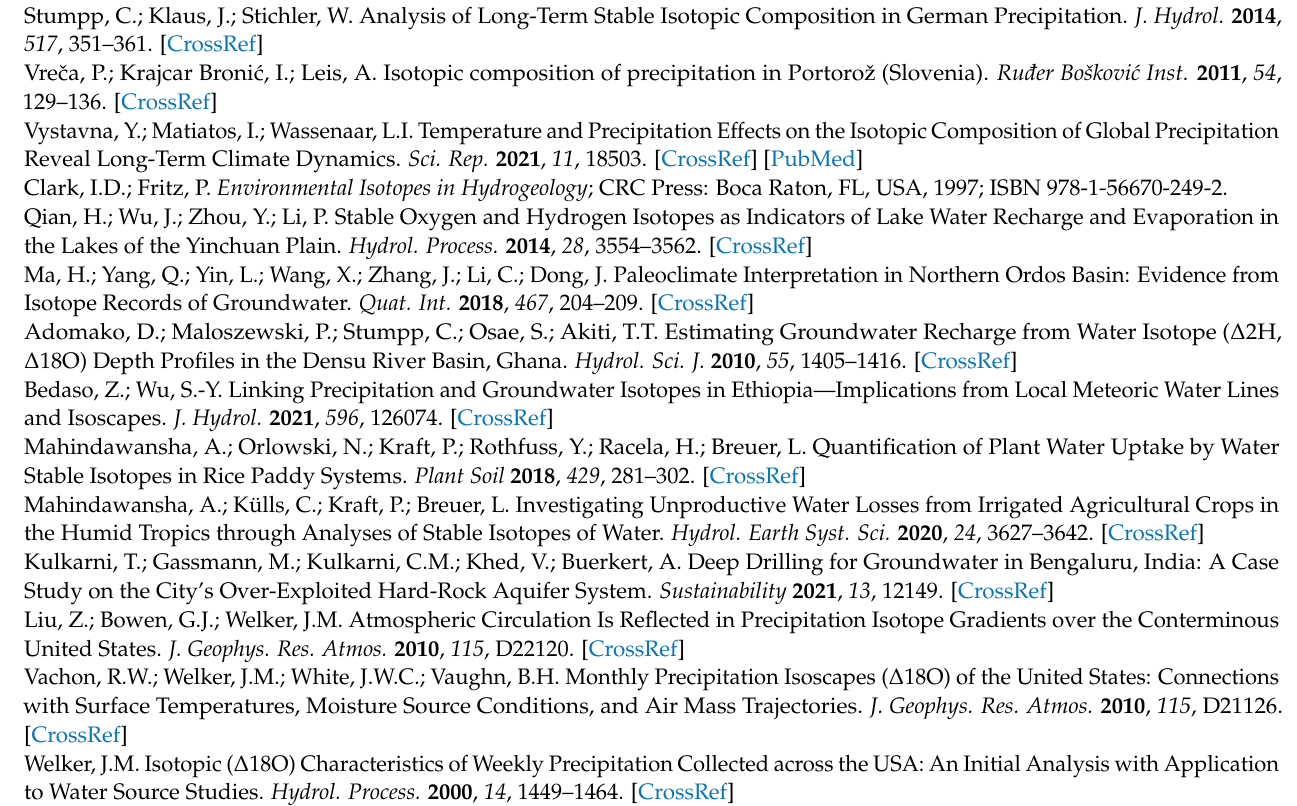
Figure A2. Fluctuations of climatic variables, precipitation ( a ), temperature ( b ), relative humidity— RH ( c ), wind speed ( d ) variation during the experimental years